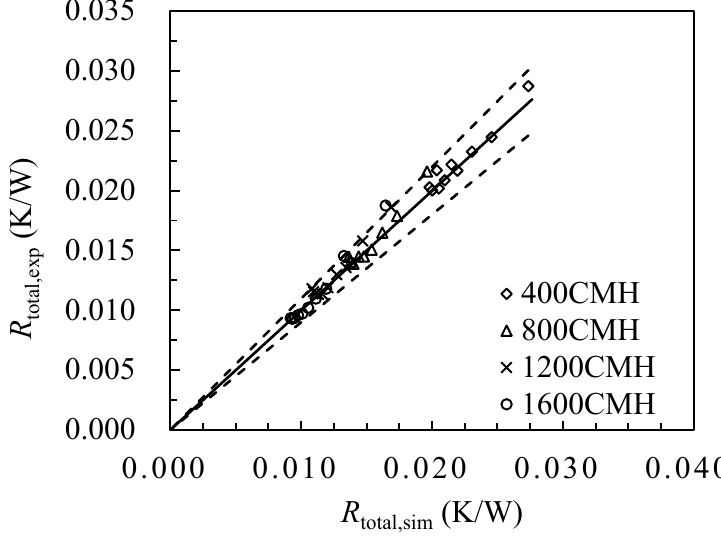
Figure 8. A comparison of experimental and theoretical total resistances under various cooling air flow rates.